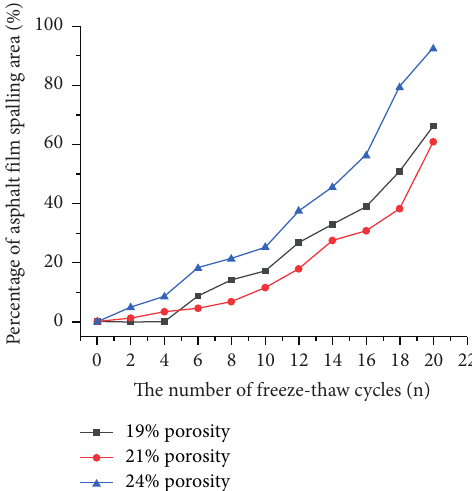
Figure 10: Peeling area changes of the asphalt film with the number of freeze-thaw cycles. Table 1: Percentage of the asphalt film spalling area of the samples with different porosities under multiple freeze-thaw cycles. Number of freeze-thaw